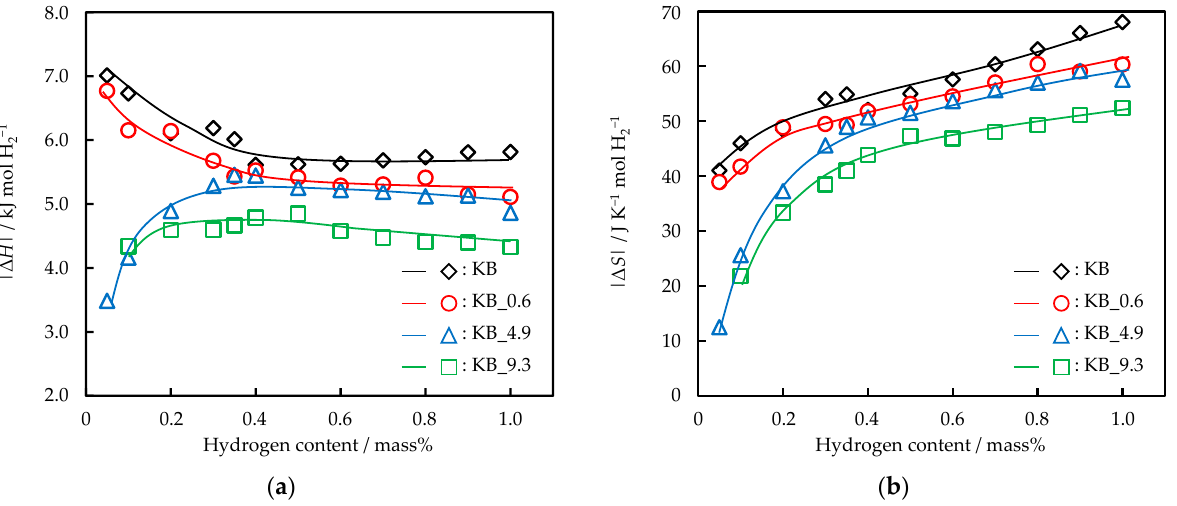
Figure 10. Variation of ( a ) | Δ H | and ( b ) | Δ S | with hydrogen content for KB, KB_0.6, KB_4.9, and KB_9.3. Table 2. Enthalpies of hydrogen adsorption on various amorphous carbons.